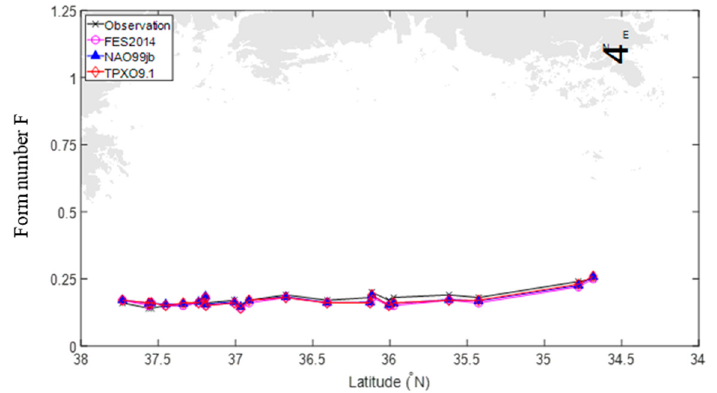
Figure 3. The value of the form number ( F ) in the WCK. Grey color in the background shows the WCK, from left to right corresponding to north to south.